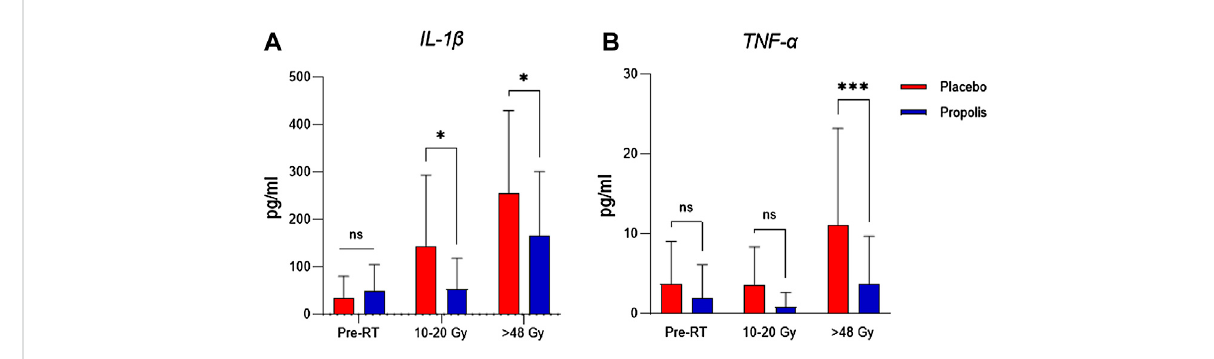
FIGURE 5 Pro-in fl ammatory cytokine IL1- β (A) is reduced in the early treatment phase whereas TNF- α (B) is decreased in fi nal phase.